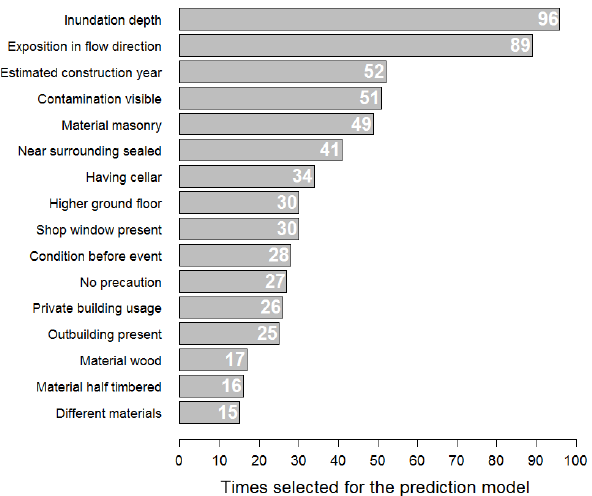
Figure 2. Random generalized linear model feature importance (times selected) for the response variable damage